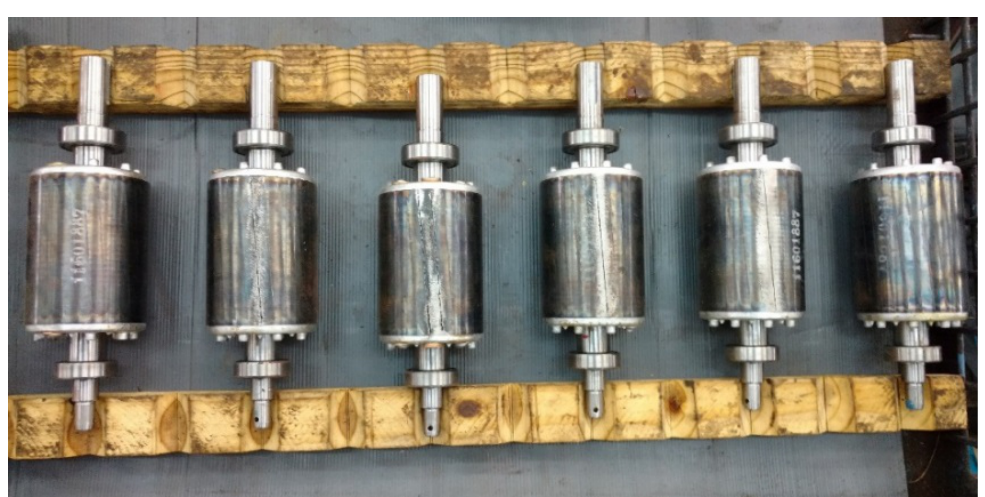
Figure 1. Test bench setup.